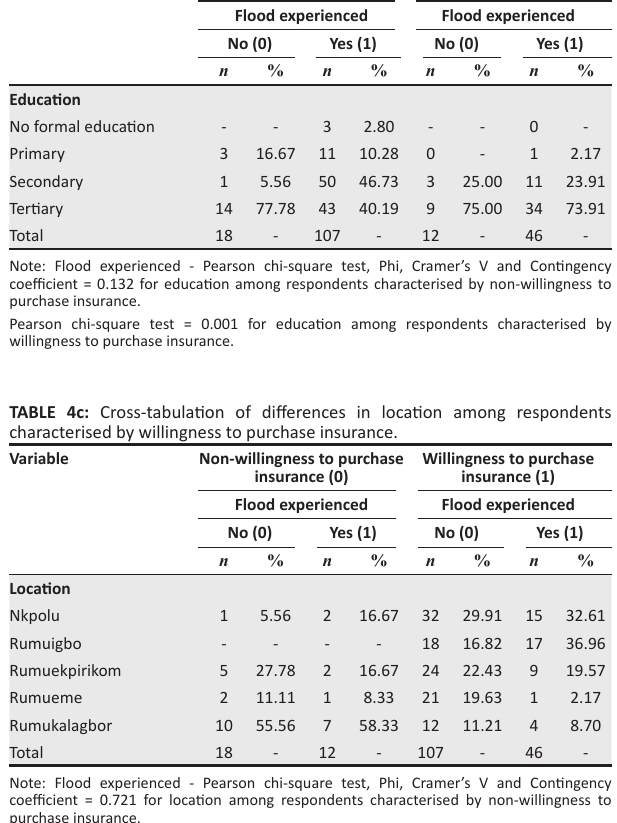
TABLE 4b: Cross - tabulation of differences in education among respondents characterised by willingness to purchase insurance . Variable